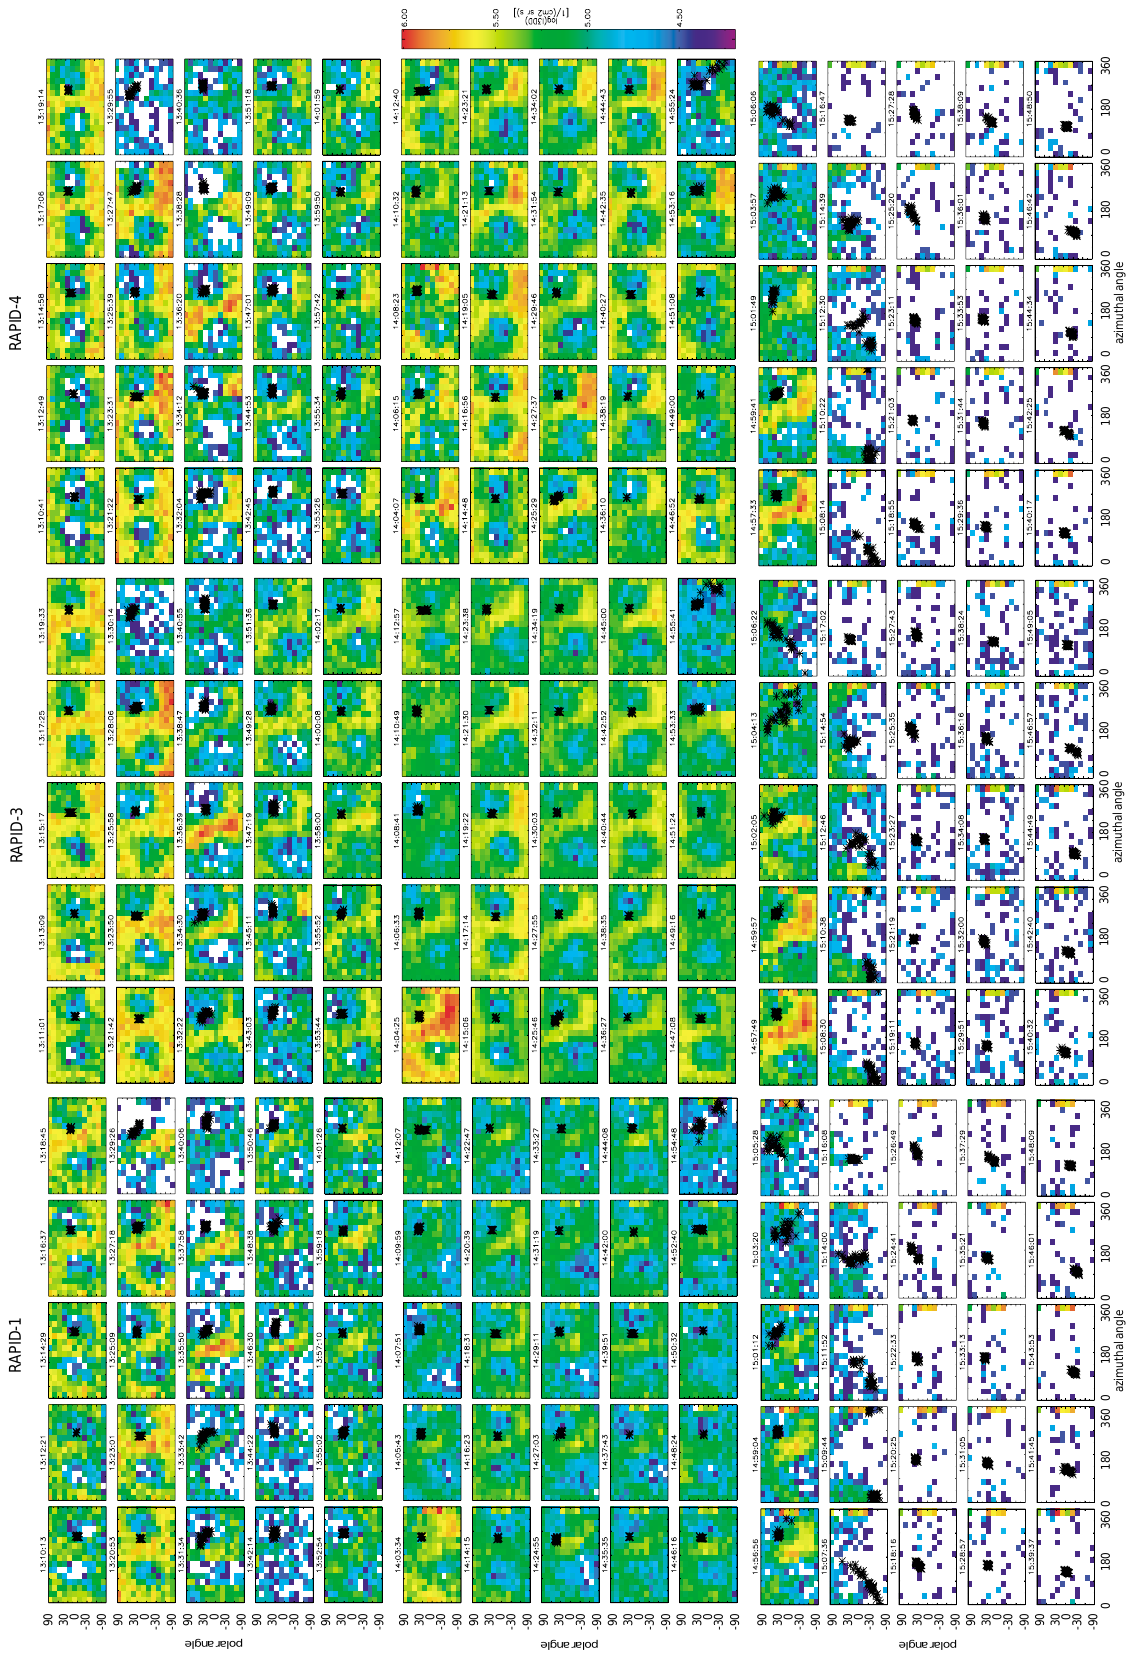
Fig. 7. Polar-azimuthal plots of H flux measured by RAPID on spacecraft 1, 3, 4 on 14 January 2001 between 13:10 and 15:48